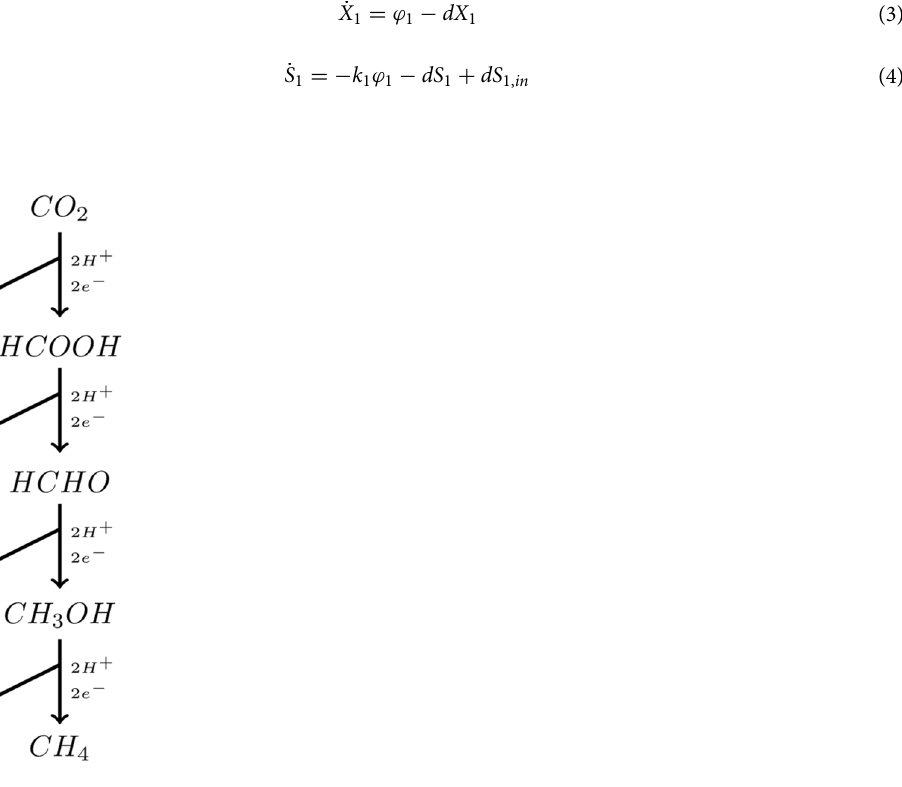
Figure 2. Methanogenesis by CO 2